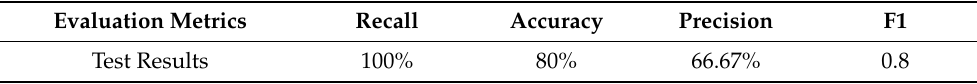
Table 2. Results of the detection of mulberry diseases by the described method. Evaluation